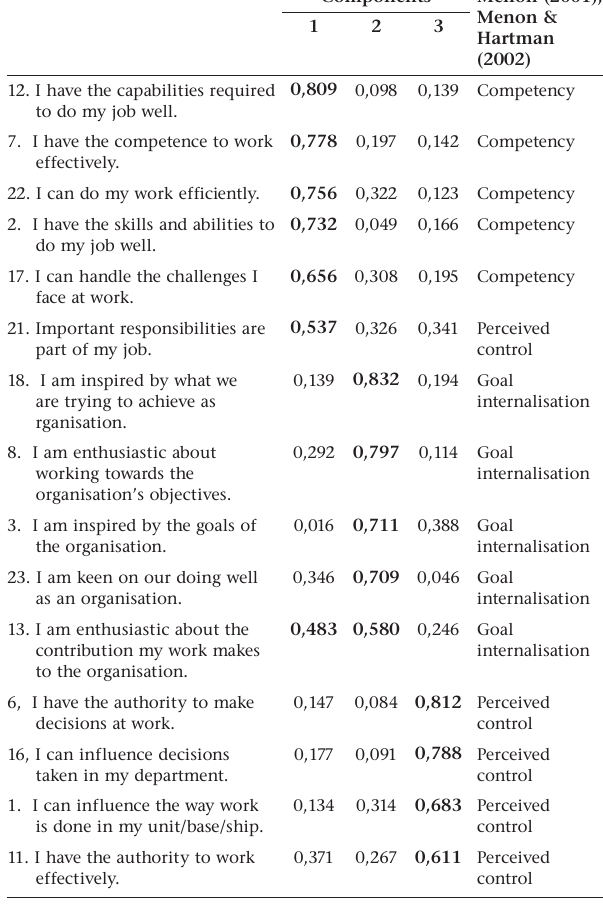
Extraction Method: Principal Component analysis. Rotation Method: Varimax with Kaiser normalization. rotation converged in 5 iterations.